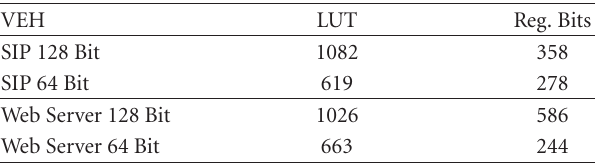
Table 6: Synthesis results for 128b and 64 b VEHs.